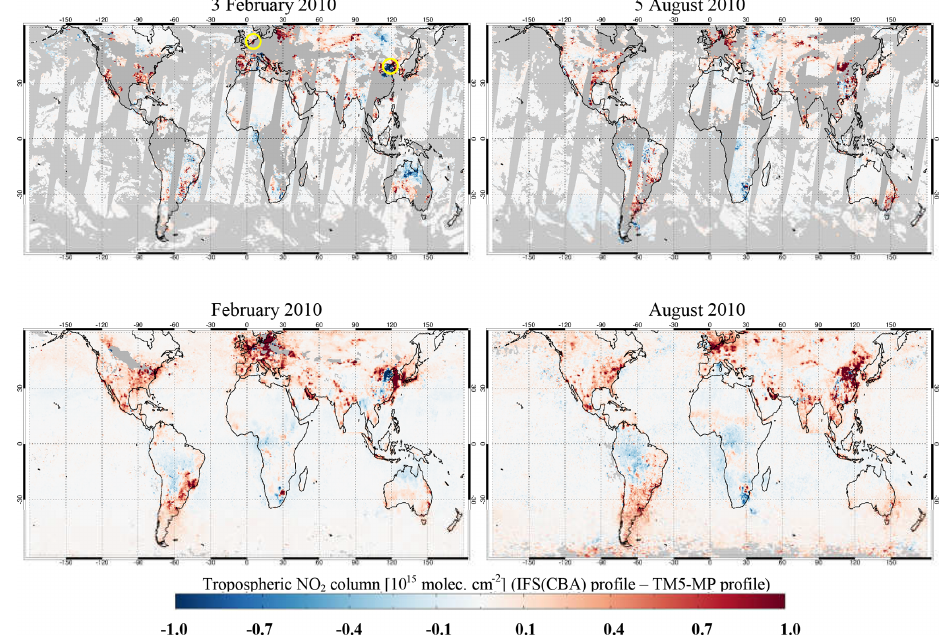
Figure 8. Differences in tropospheric NO 2 columns retrieved using TM5-MP and IFS (CBA) a priori NO 2 profiles for a given day and for the monthly average in February and August 2010. Yellow circles in the top-left panel indicate the locations utilised in Fig. 7. Only measurements with a cloud radiance fraction less than 0.5 are